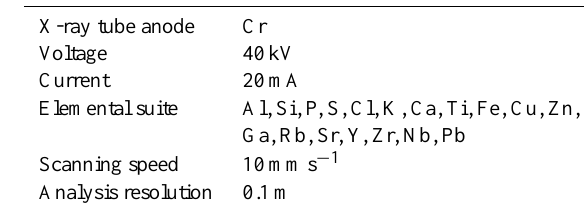
Table 2. Specifications of the analytical parameters used for scan- ning the COSC-1 drill core with the new